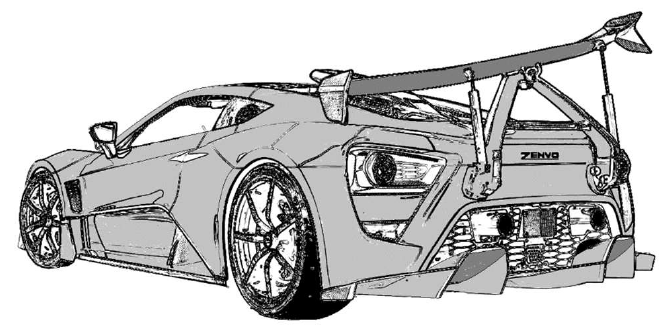
Figure 1. Solution of movable rear wing realized by Zenvo.